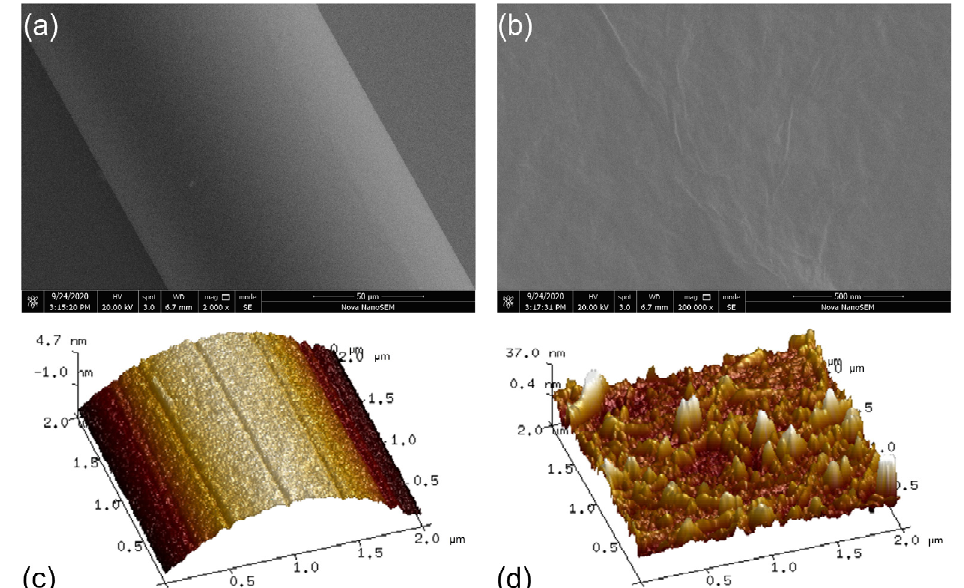
Figure 6. ( a ) Scanning electron microscope analysis of the GO-coated FBG sensor. ( b ) Observation of the GO-coating on the cladding surface. Atomic force microscope analysis of FBG sensor before ( c ) and after ( d ) GO-coating.